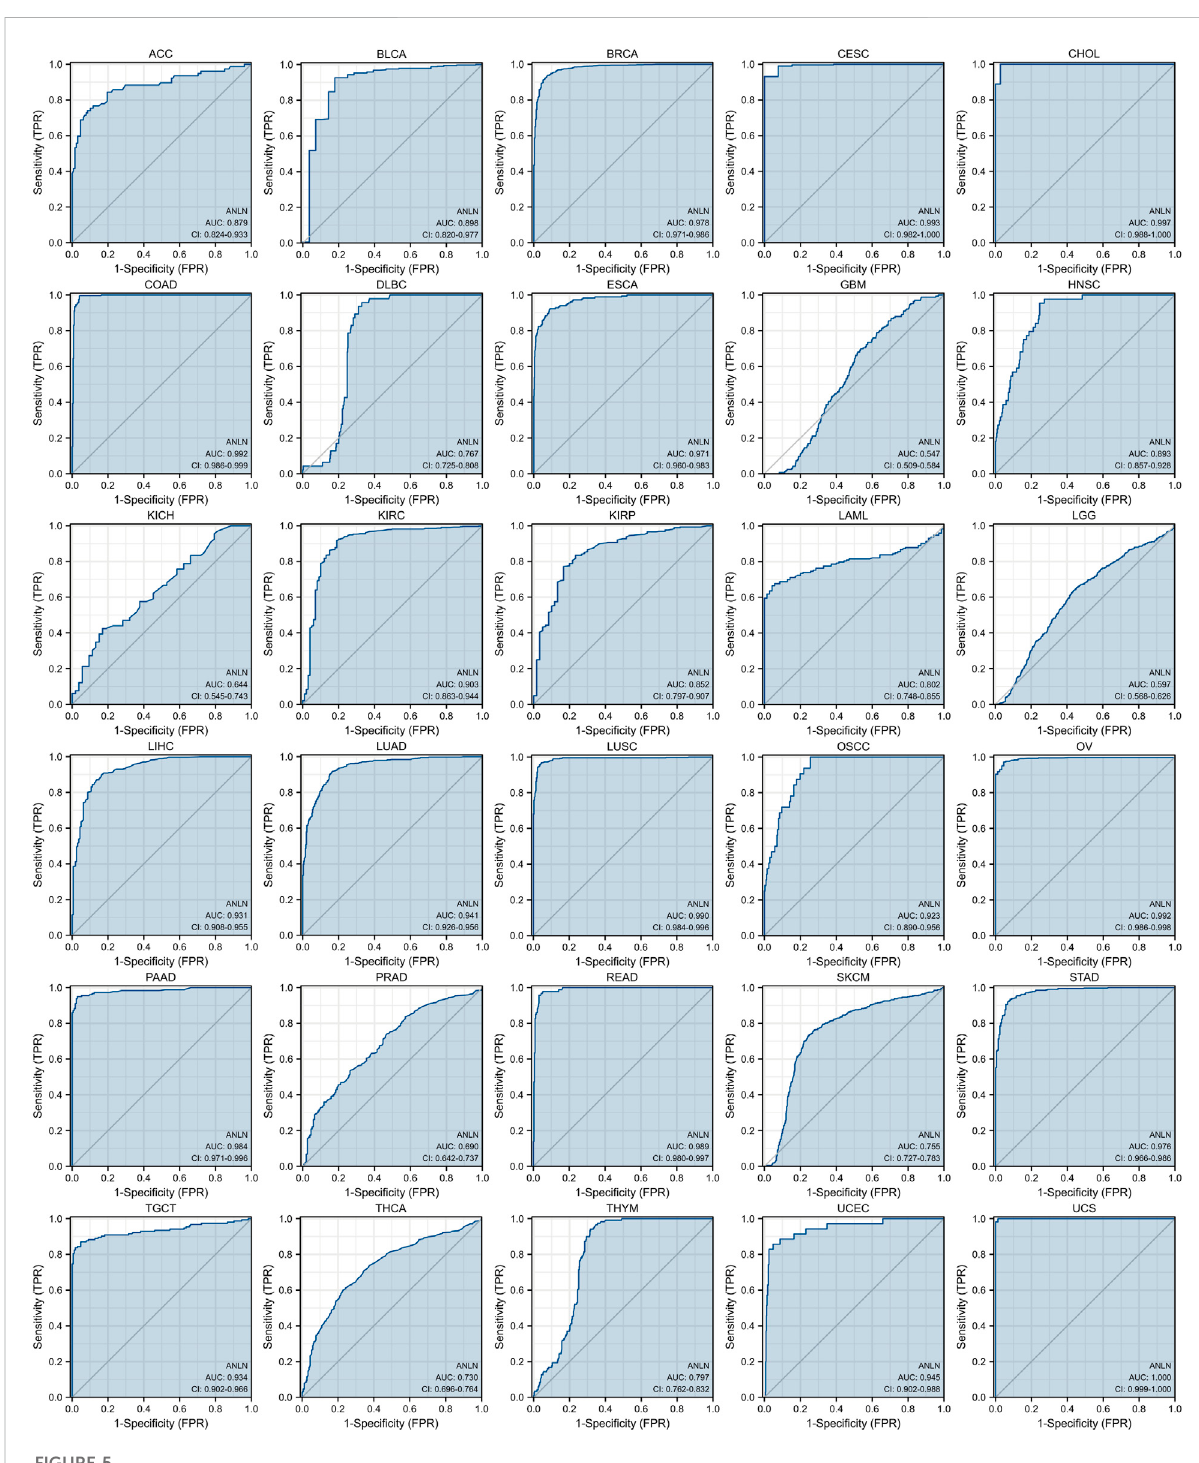
FIGURE 5 ROC curves indicate that ANLN has good discrimination power between tumor and normal tissues in pan-cancer. The X -axis represents the false positive rate (FPR), and the Y -axis represents the true positive rate (TPR). The larger the area under the curve (AUC), the higher the predictive